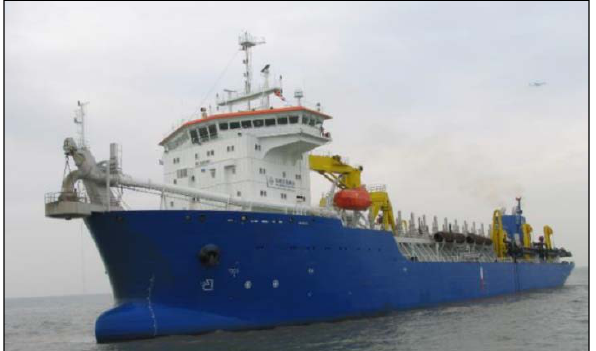
Figure 5. Photo of the rake suction dredger during the test.